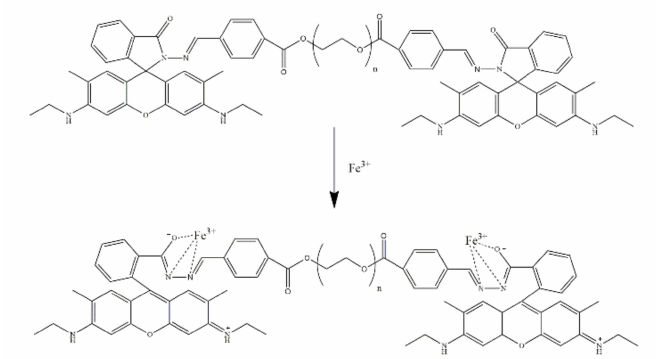
Figure 28. The proposed coordination mechanism of DRF-PEG (Table 1, No. 35) towards Fe 3+